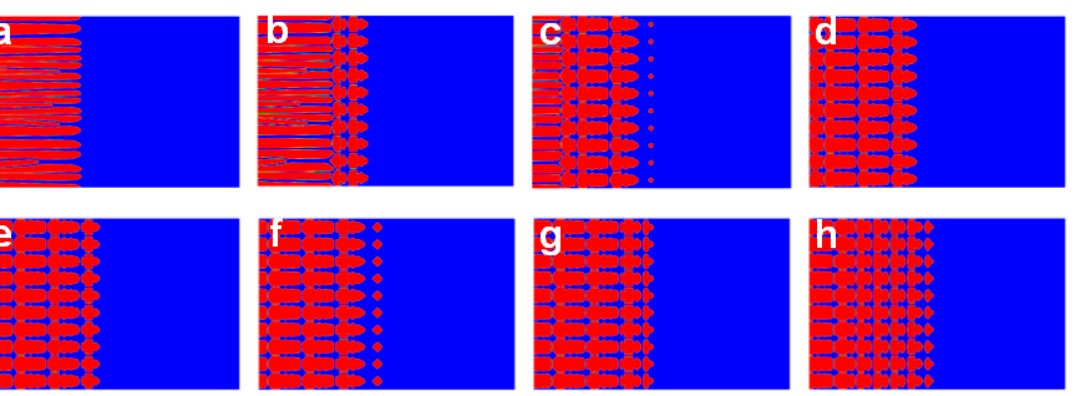
Figure 6. The microstructure evolution at di ff erent time step: ( a ) 7.0 × 10 5 (35.0% of the total simulation time); ( b ) 7.3 × 10 5 (36.5% of the total simulation time); ( c ) 7.8 × 10 5 (39.0% of the total simulation time); ( d ) 8.1 × 10 5 (40.5% of the total simulation time); ( e ) 8.6 × 10 5 (43.0% of the total simulation time); ( f ) 9.1 × 10 5 (45.5% of the total simulation time); ( g ) 9.6 × 10 5 (48.0% of the total simulation time); ( h ) 1.01 × 10 6 (50.5% of the total simulation time).